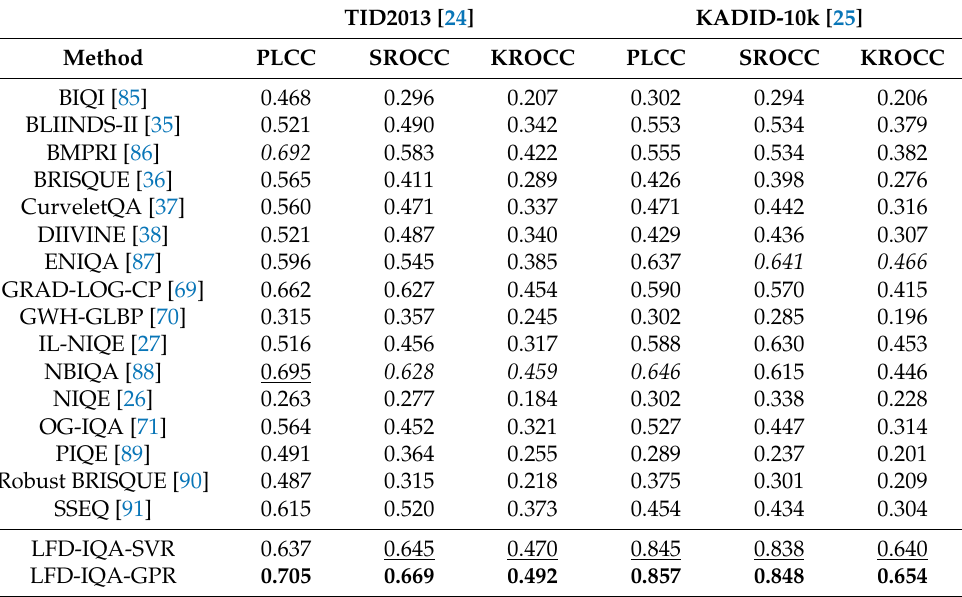
Table 4. Comparison to the state-of-the-art on TID2013 [24] and KADID-10k [25] databases. Median PLCC, SROCC, and KROCC values were measured over 100 random train-test splits carried out with respect to the reference images. The best results are typed in bold, the second best results are underlined, and the third best results are typed in italic.